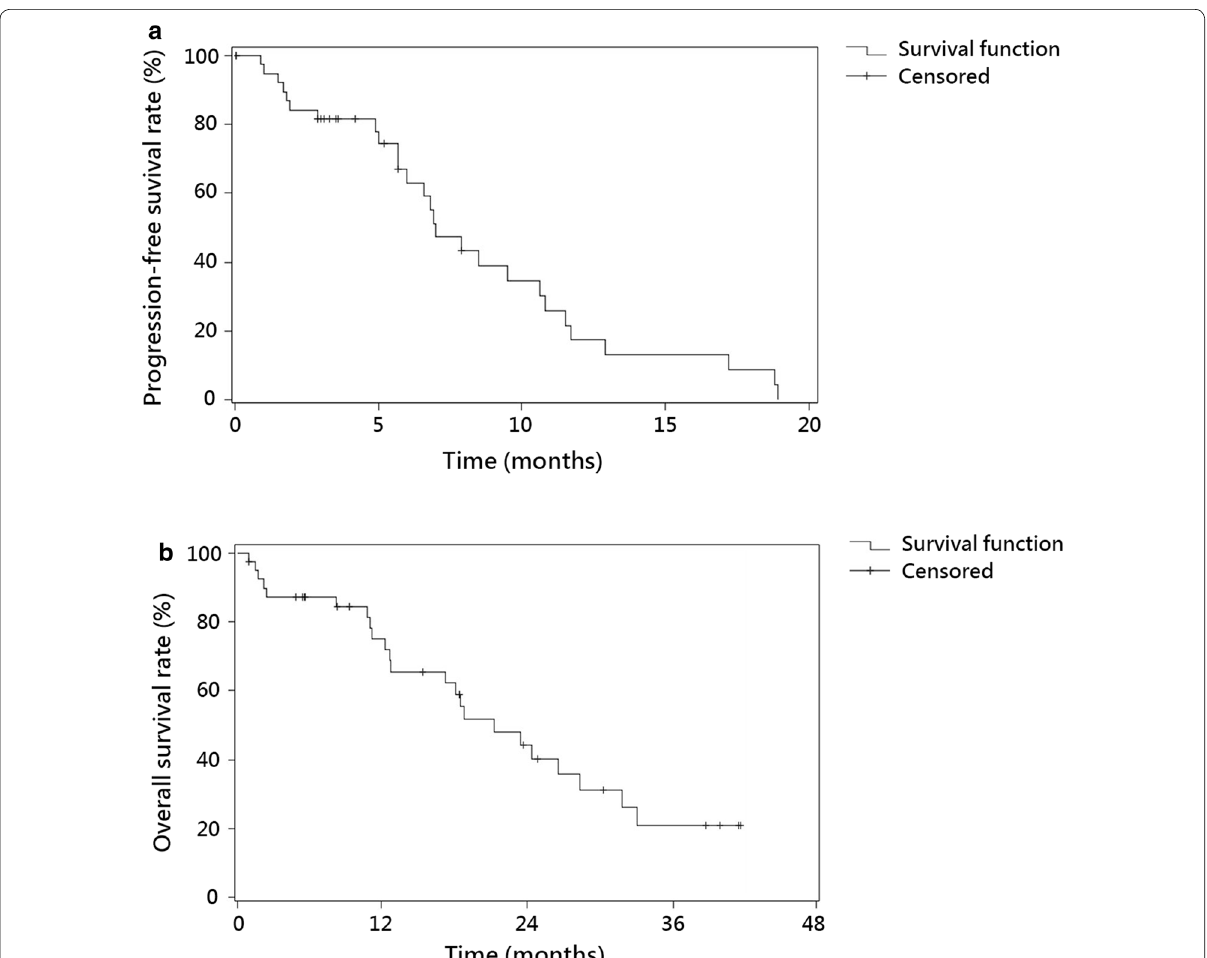
Fig. 1 Kaplan‑Meier curves of progression‑free survival and overall survival for 40 Chinese patients with metastatic colorectal cancer. a The esti‑ mated progression‑free survival was 7.0 months (95% confidence interval [CI] 6.0–10.6 months). b The estimated overall survival was 22.2 months (95% CI 15.1–29.3